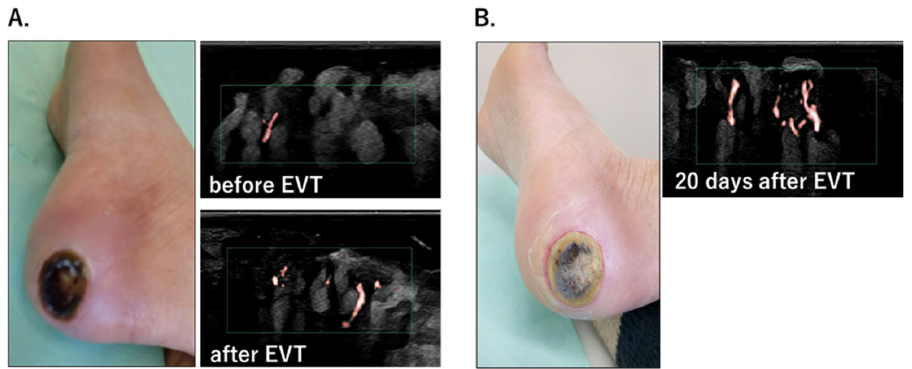
Figure 5. ( A ). Heel ulcer and wound ‐ tissue microcirculation before and after EVT. SMI captured the improvement in microcirculation immediately after EVT. ( B ). The ulcer healed gradually, and